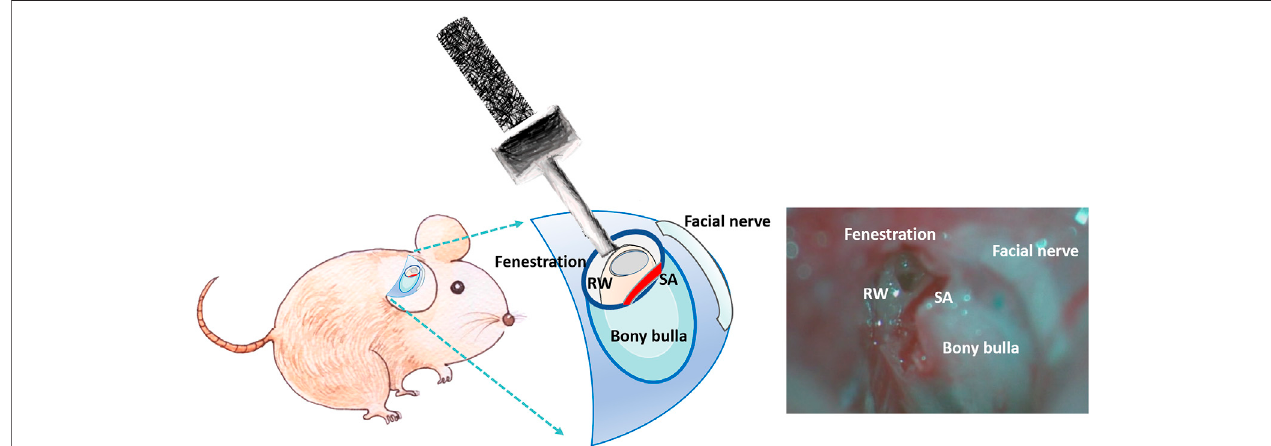
FIGURE 2 | Schematic of the procedure for in vivo application of USMBs in the opened tympanic